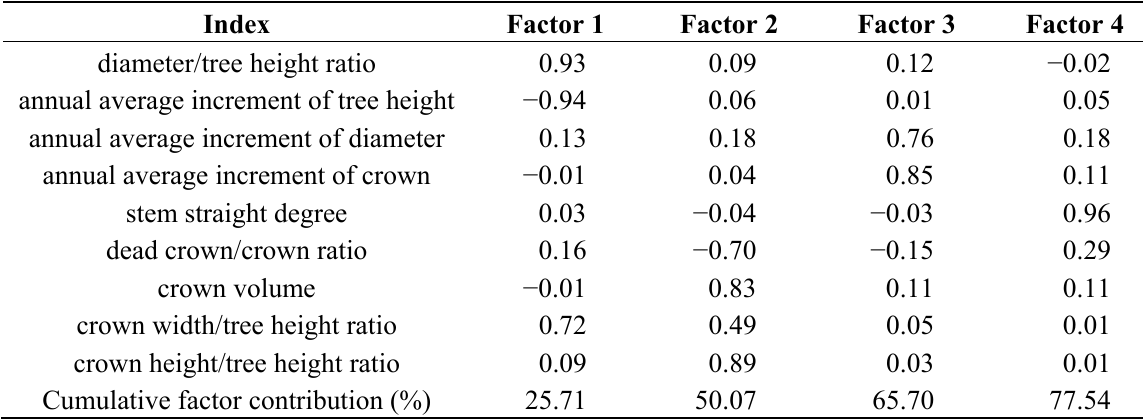
Table 6. Rotated component matrix of 4 factors for 9